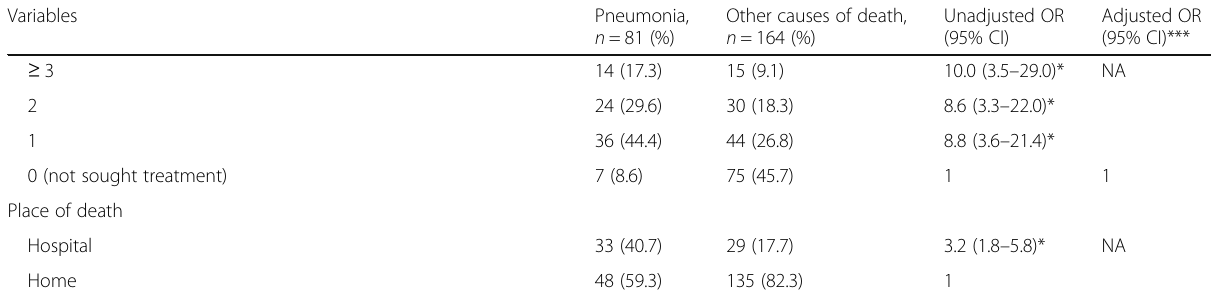
Table 2 Correlates of pneumonia deaths compared to other causes of deaths in children aged 4 weeks to 59 months in rural Bangladesh ( n = 245)